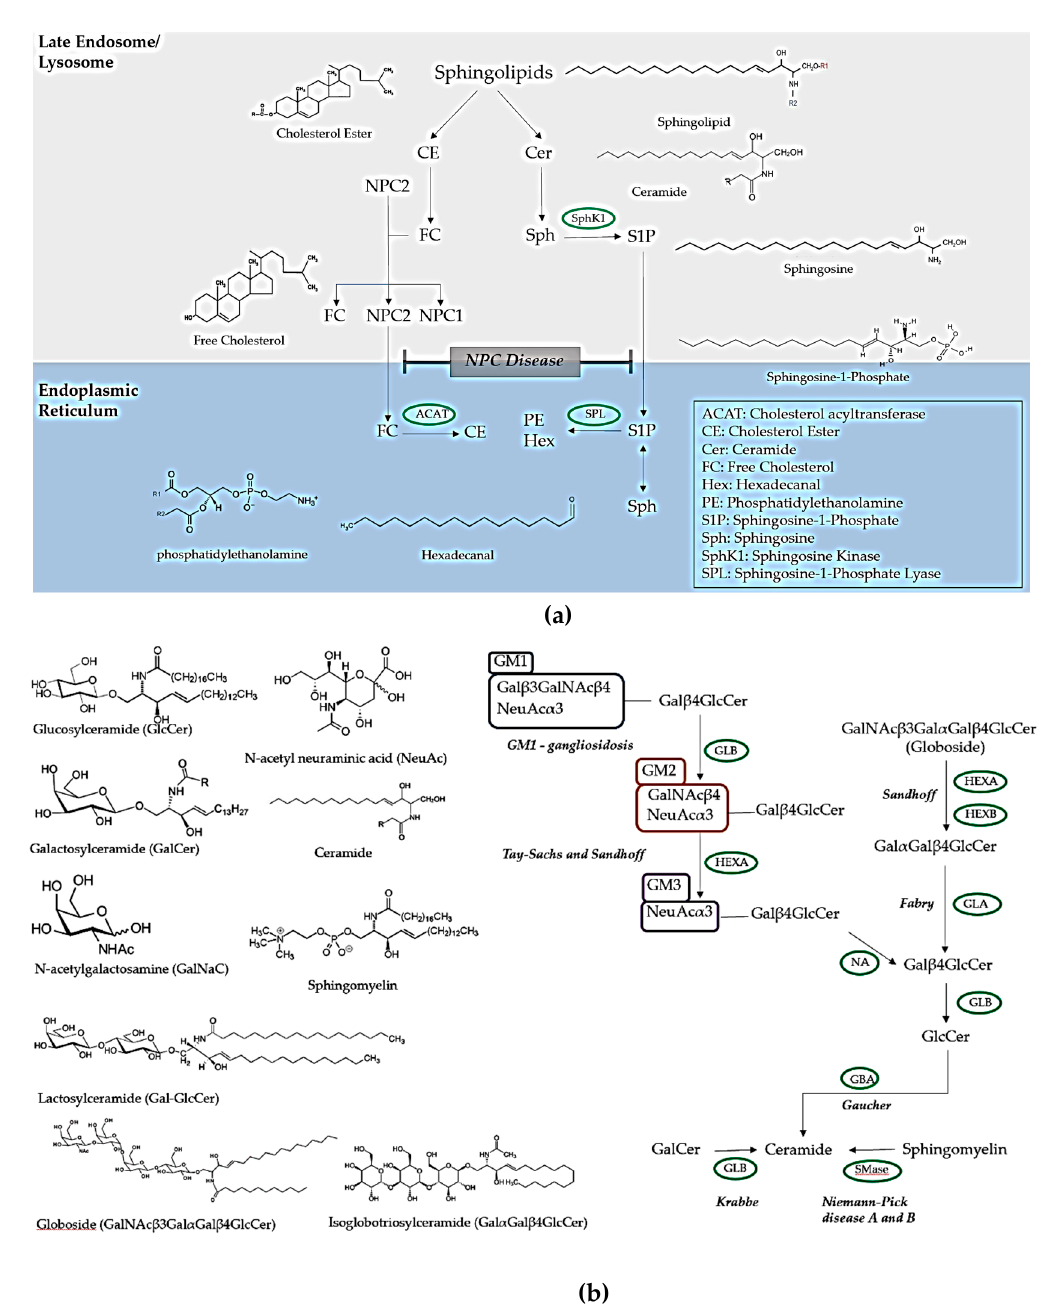
Figure 1: Metabolism of lipidoses ( a ) Impact of lipid trafficking in Niemann-Pick type C disease. ( b ) Impact of lipid metabolism in other lysosomal storage disorders. Abbreviations: ACAT, Cholesterol acyltransferase; CE, Cholesterol Ester; FC, Free Cholesterol; Hex, Hexadecanal; PE, Phosphatidylethanolamine; S1P, Sphingosine-1-Phosphate; Sph, Sphingosine; SphK1, Sphingosine Kinase; Sphingosine-1-Phosphate-Lyase; GlcCer, Glucosylceramide; NeuAc; N -acetyl nueraminc acid, GalCer, Galactosylceramide; Gal-GlcCer, Lactosylceramide; GalNAc β 3Gal α Gal β 4GlcCer, Globoside; Gal α Gal β 4GlcCer, Isoglobotriosylceramide. Table 1. Gene defects and approved therapies for lipid storage disorders.